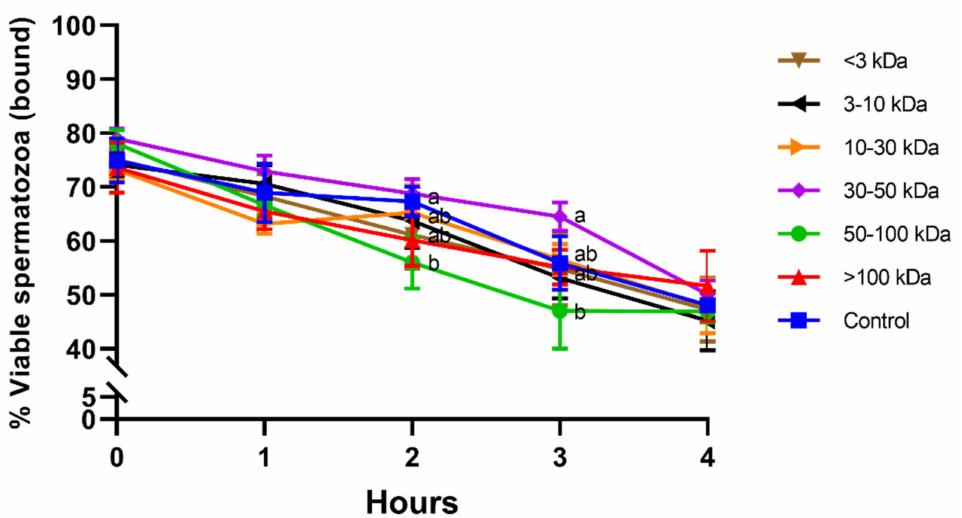
Figure 3. Percentages of viable spermatozoa in the bound-to-PMN for different seminal plasma fractions and throughout incubation at 38 ◦ C for 4 h. Different superscripts (a,b) mean significant differences between seminal plasma fractions within a given time point ( p ≤ 0.05). Data are shown as mean ± SD for 12 independent experiments.